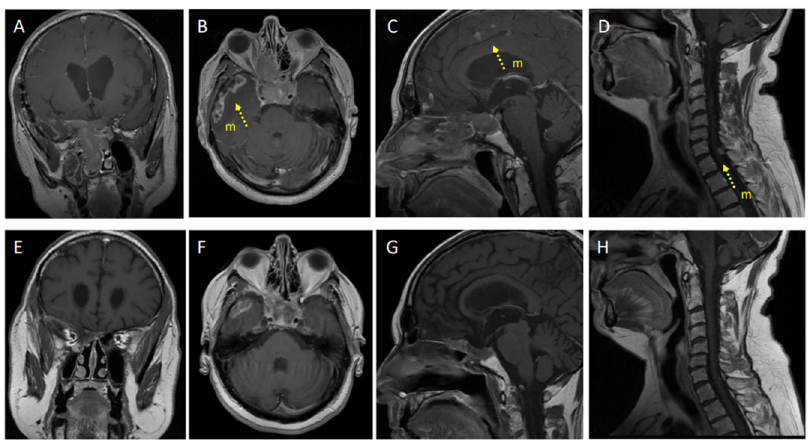
Figure 3. Radiological response to pembrolizumab: Shown are representative MRI obtained before ( A – D ) and after 1 year of treatment ( E – H ) in the patient affected by a silent metastatic Pit1-positive PitNET. Coronal ( A , E ) and axial ( B , F ) T1-weighted sequences post-gadolinium, show a regrowth of the sellar mass inferiorly with nasal obstruction ( A ), with anterior spread to the right retrobulbar optic area ( B ), and tumor shrinkage (>70%) after pembrolizumab with the persistence of minimal tissue of uncertain significance at the primary site ( E , F ). Sagittal T1-weighted sequence post-gadolinium ( C , G ) showing brain dissemination with the appearance of multiple, small and asymptomatic multiple metastases (m, yellow arrow)—the necrotic aspect of a metastatic site which previously received stereotactic radiotherapy along with metronomic temozolomide can also be recognized in ( C ), and their subsequent disappearance after pembrolizumab. ( G ) Spinal sagittal T1-weighted sequence post-gadolinium ( D , H ) showing the progression with the main spinal metastasis at C6–D1 ( D ) (yellow arrow) which nearly disappeared after treatment ( H ).